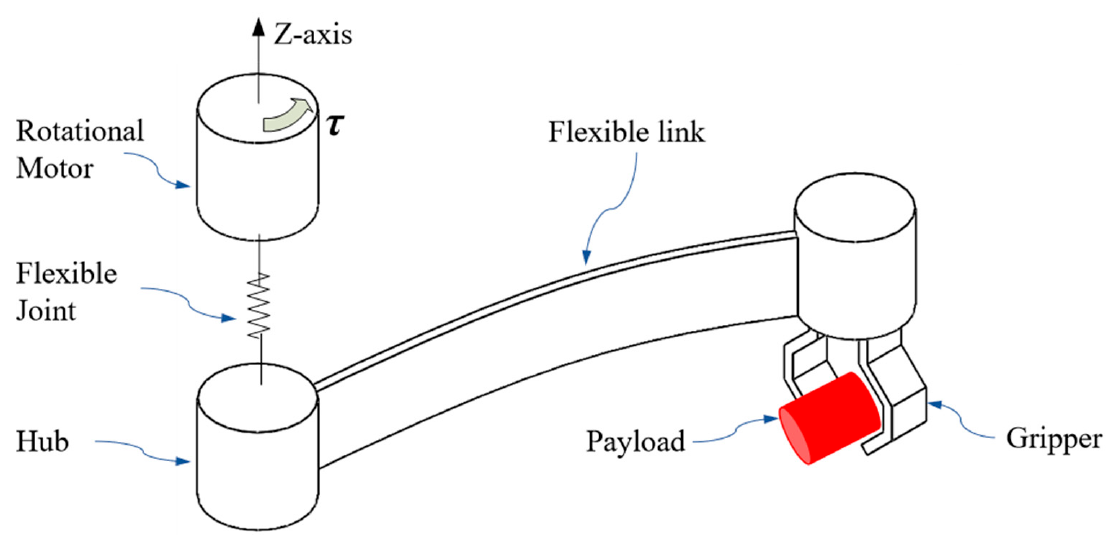
Figure 2. Sketch a single flexible-link, flexible-joint mechanism.